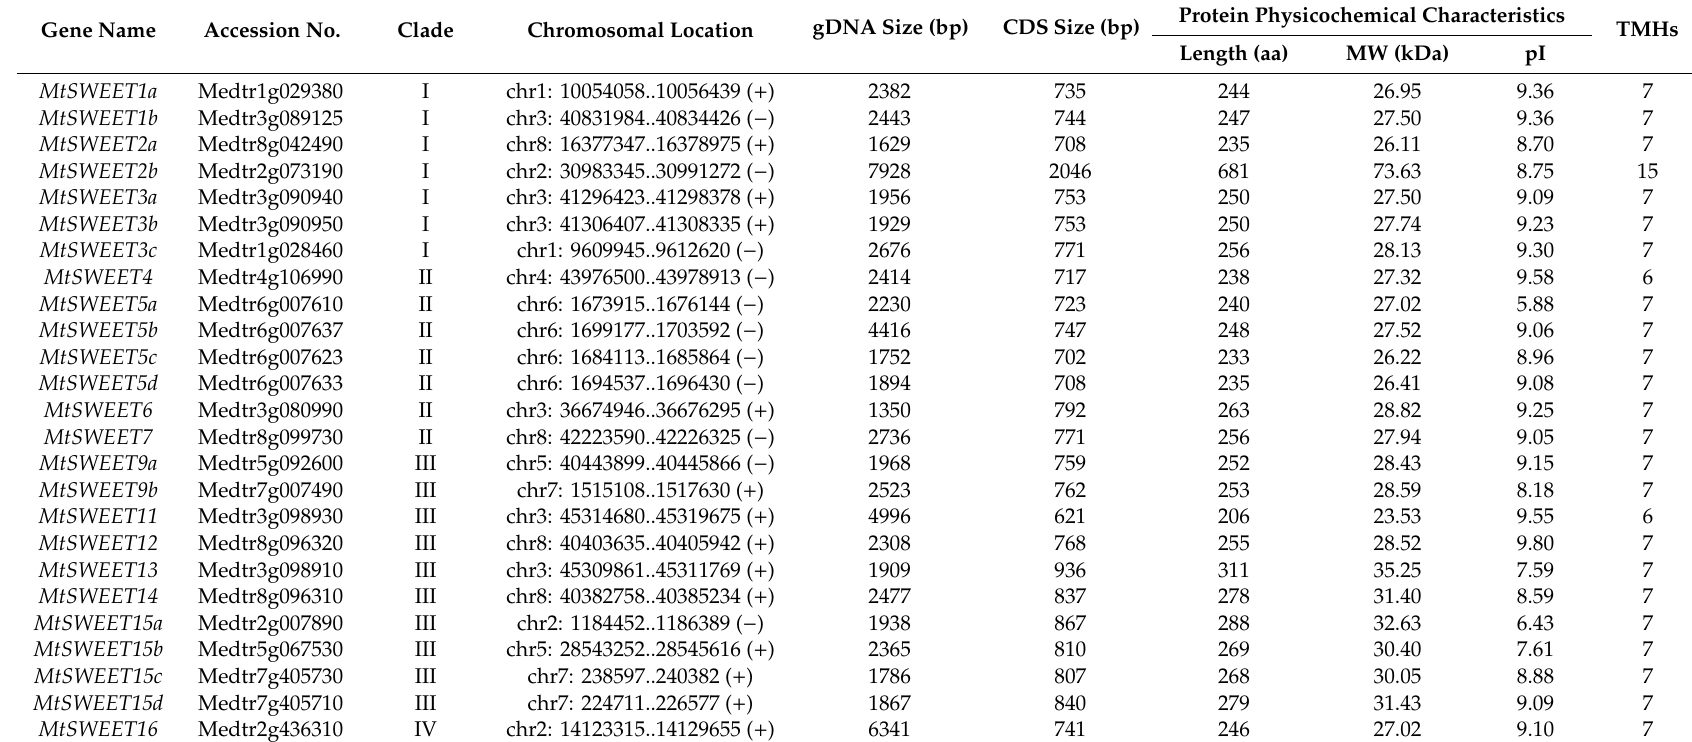
Table 1. SWEET gene family in Medicago truncatula